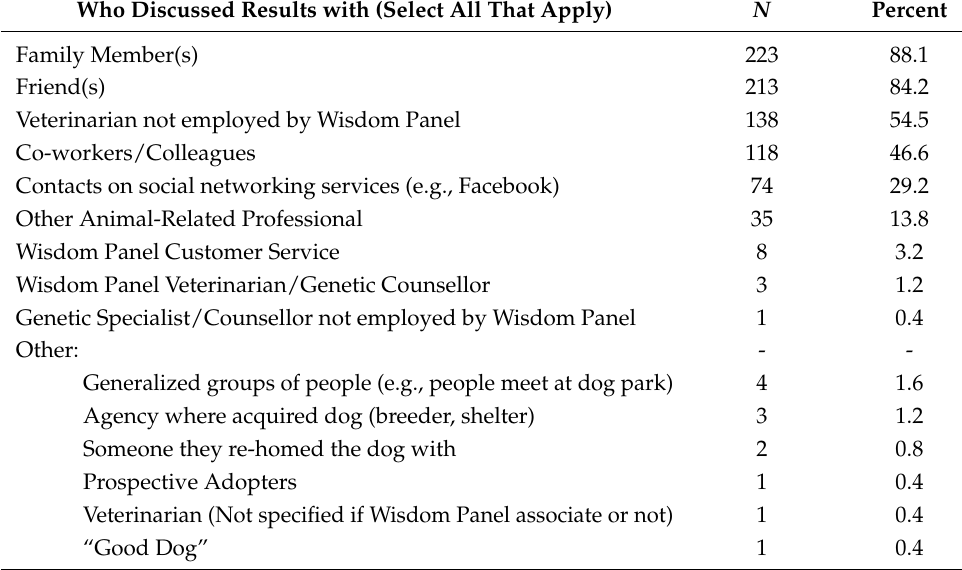
Table 6. Participant data about who they discussed their dog’s genetic test results with. Who Discussed Results with (Select All That